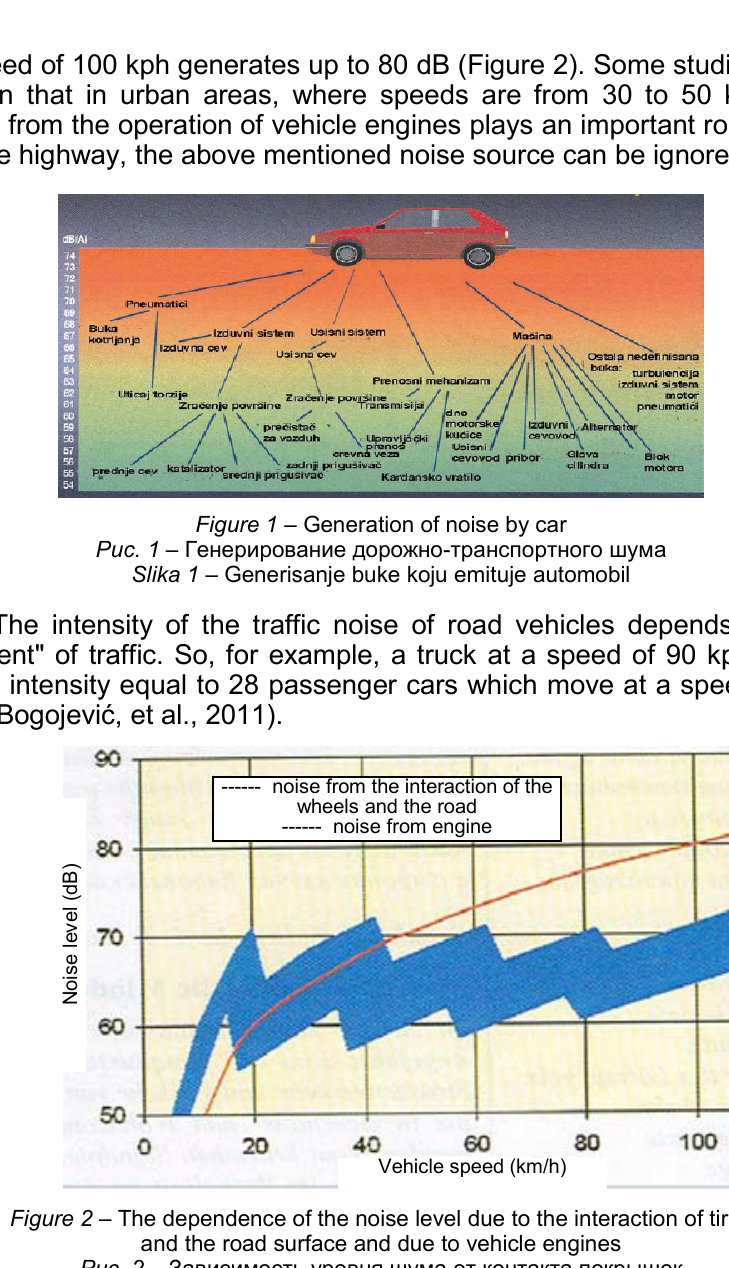
Рис . 2 – Зависимость уровня шума от контакта